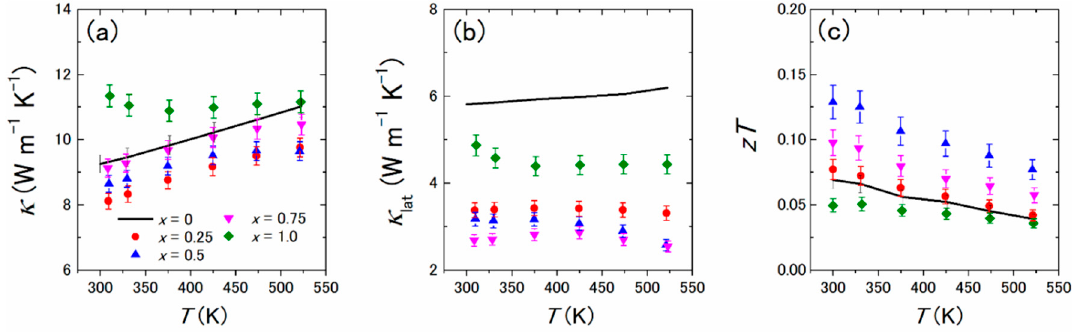
Figure 10. Temperature dependences of ( a ) total thermal conductivity κ , ( b ) lattice thermal conductivity κ lat , and ( c ) dimensionless figure of merit zT for polycrystalline bulk samples of Yb(Si 1 − x Ge x ) 2 − δ ( x = 0, 0.25, 0.50, 0.75, and 1.0). Reproduced with permission from Ref. [36]. Copyright 2018, AIP Publishing.